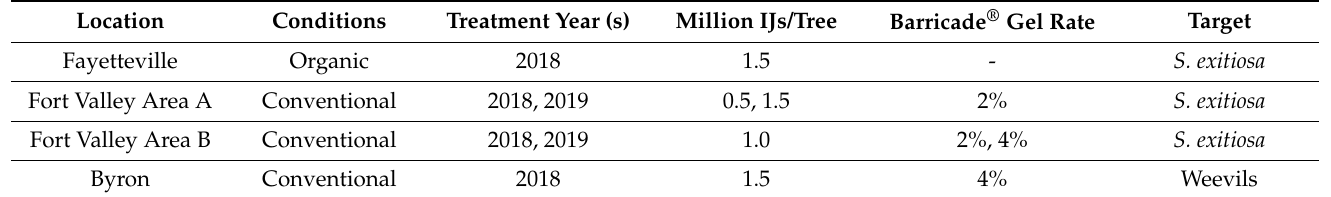
Table 1. Experimental setup across different field locations. The ‘years treated’ column lists the years in which a fall treatment was made, and in which data were collected the following spring. The weevils target is referring to all root-feeding weevils as secondary pests of